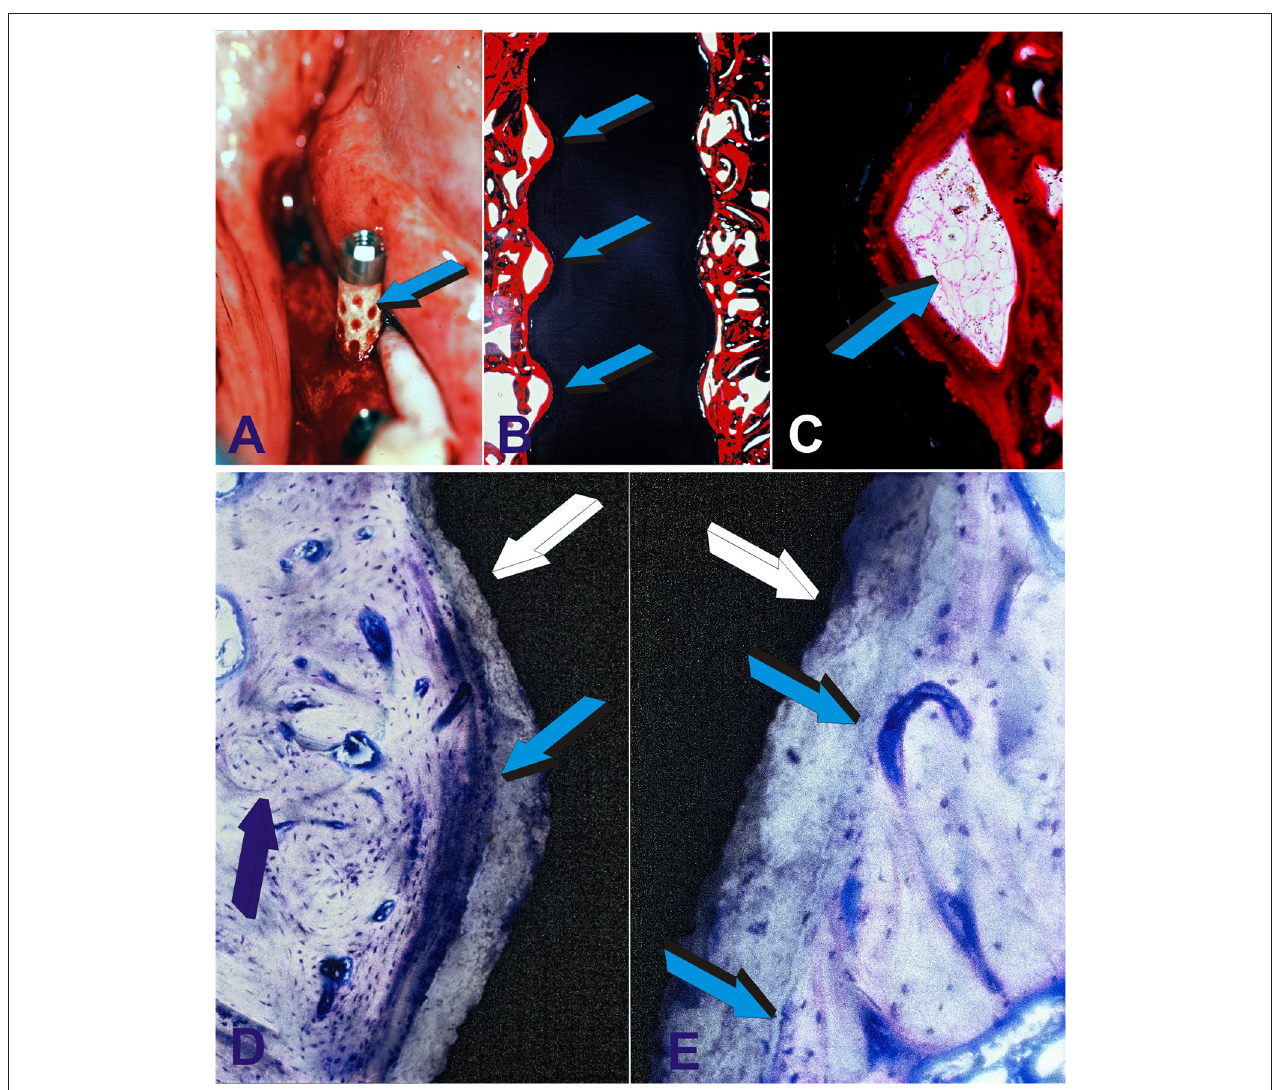
FIGURE 8 | Preclinical testing of the geometric self-inductive constructs in edentulous mandibular ridges of adult Chacma baboons Papio ursinus . (A) Highly crystalline hydroxyapatite coated titanium geometric constructs are implanted in edentulous ridges of adult Papio ursinus . Note the selected concentration/adsorption of plasma and plasma products onto the concavities of the geometric implant (light blue arrow). Binding of plasma and/or serum material onto the concavities may possibly act as a reservoir of plasma factors including fibrin and fibronectin for (B) early attachment along the severed bone inducing continuous osteointegration with newly formed bone tightly attached along the concavities of the implanted bioreactor with (C) remodeling bone with marrow within the inductive concavity of the implanted bioreactor. (D) Tight osteointegration to the sintered hydroxyapatite coated titanium construct (light blue arrow) with newly formed lamellar osteonic bone (dark blue arrow) tightly attached to the plasma sprayed hydroxyapatite coating onto the titanium substratum (white arrow). (E) High power view digital image showing the tight and remodeled fusion and osteointegration of the newly formed synthesized bone within a concavity of the titanium bioreactor (white arrow) coated by plasma sprayed highly crystalline sintered hydroxyapatite. Light blue arrows indicate the tight integration and biological osteointegrated blending of the newly formed bone within the concavity onto the plasma sprayed hydroxyapatite facing the lamellar osteonic bone with multiple osteocytes and capillaries along the remodeled newly formed bone